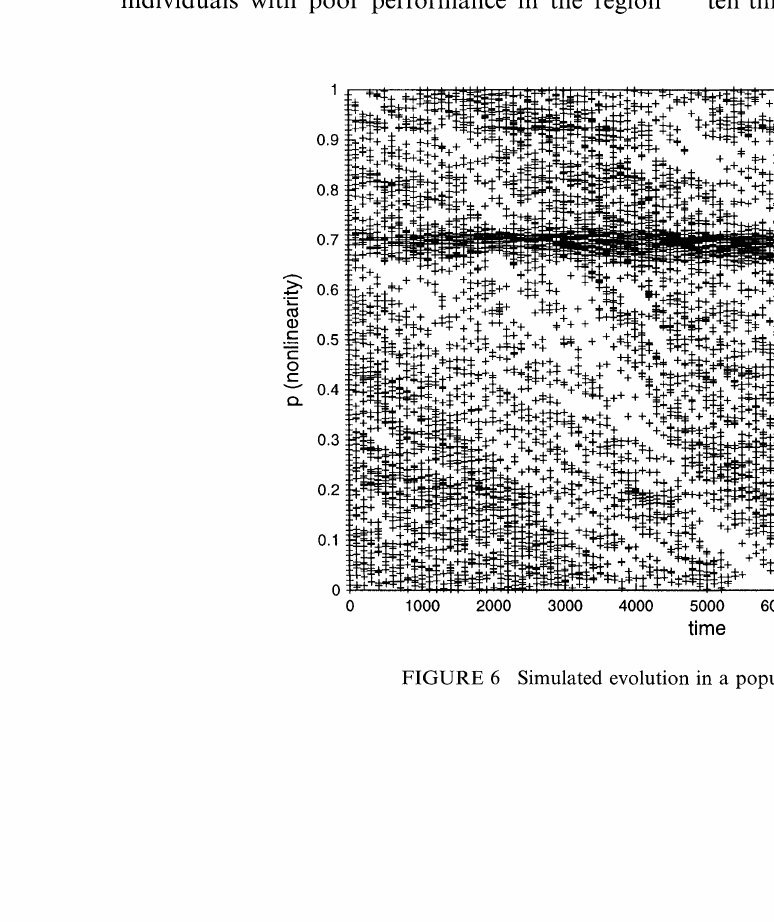
FIGURE 6 Simulated evolution in a population of 100